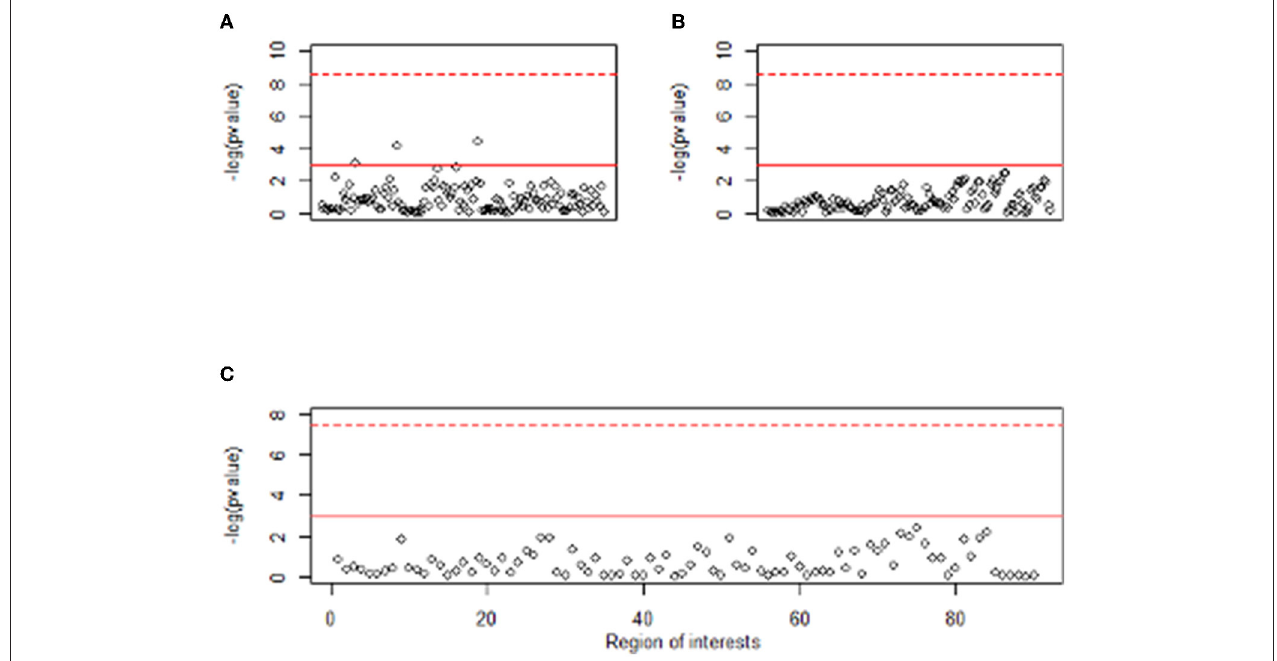
FIGURE 3 | Manhattan plot of t-test result between two groups for EEG and PET features. The y-axis of plots means –log ( p value). The x-axis of (A,B) represents the absolute power and relative power of the EEG, respectively, and the x-axis of (C) represents 90 regions of interest of PET. Dashed red line means Bonferroni level of significance and solid red line means 0.05 significance level.